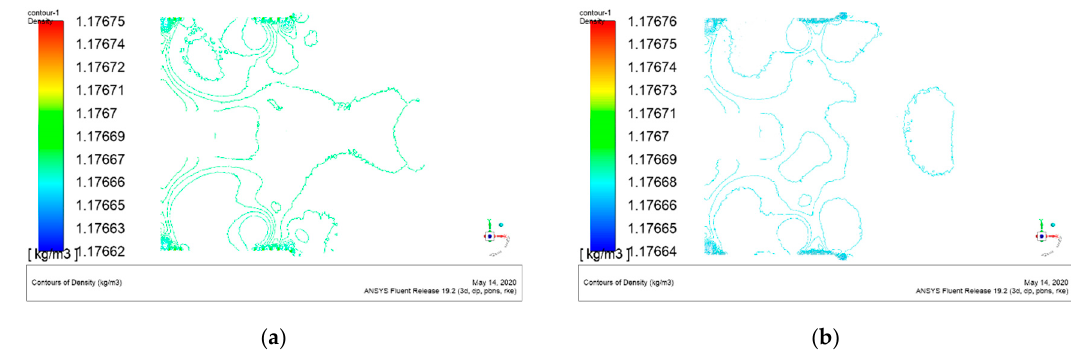
Figure 7. Contour maps of the fluid density in the beam expanding system for plans D and E: ( a ) contour map for plan D; ( b ) contour map for plan E. Table 4. P eak-to-valley (PV) and root mean square (RMS) of wavefront aberration under different schemes.